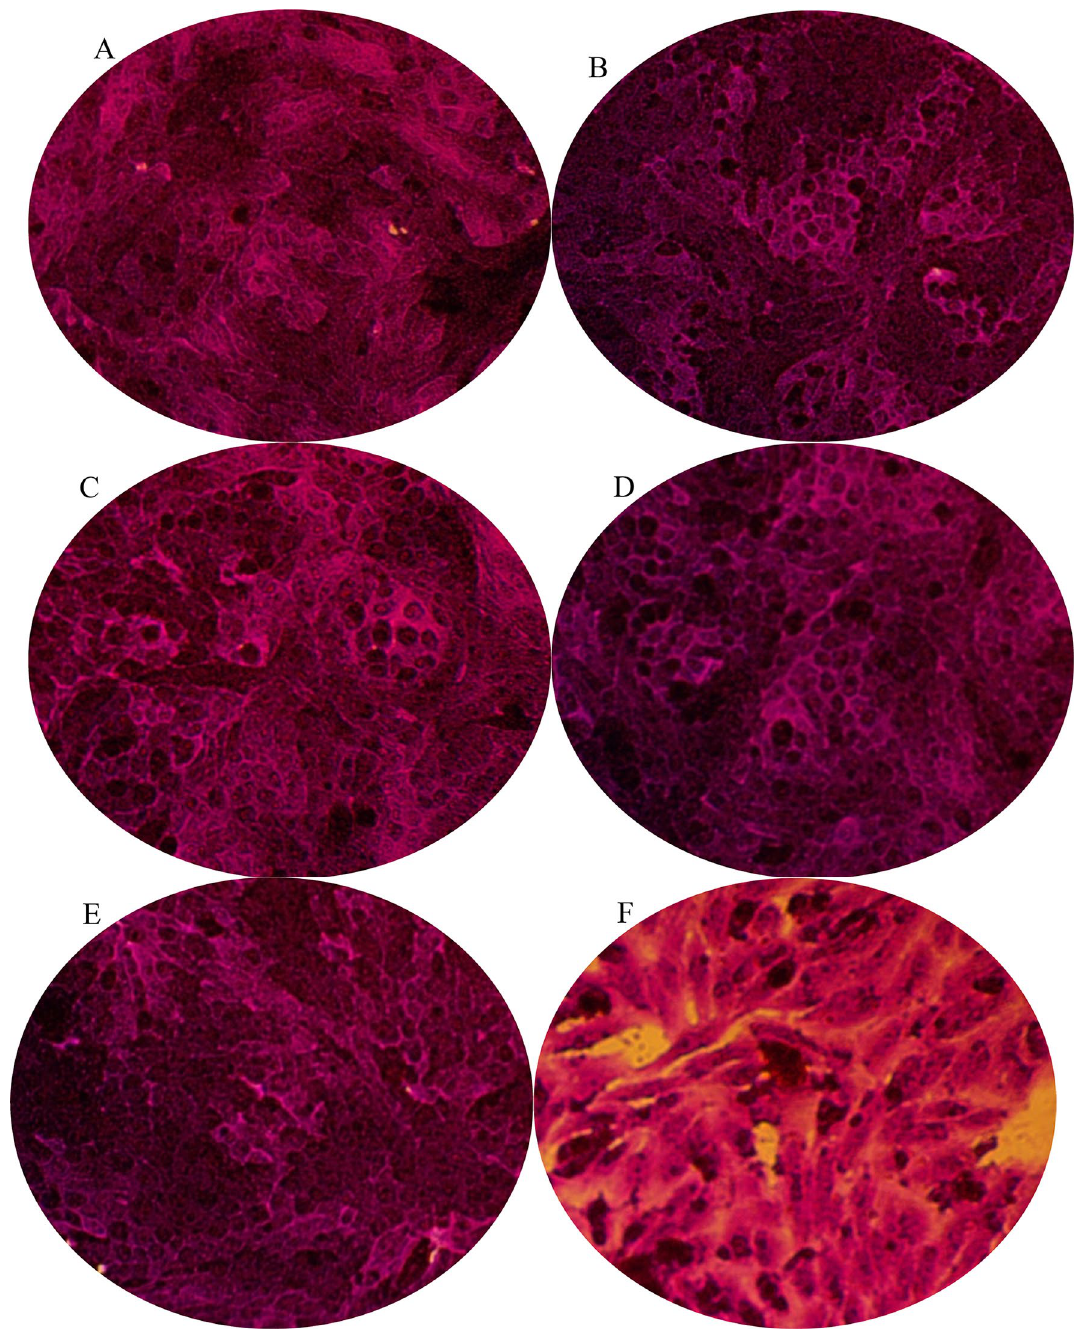
Figure 6. Morphological alteration of treated HepG2 by different concentration of D. caffra fruit extract. ( a ) control; ( b ) 0.1 µg; ( c ) 1 µg, ( d ) 10 µg; ( e ) 100 µg; ( f ) 1000 hand. The hydrogen bonds formed between the receptors and the chlorogenic acid were used to rank the bind- ing affinity and were presented as the free binding energy (S, kcal/mol). Chlorogenic acid showed the highest docking score of − 6.9689 kcal/mol with (6U7H) which is higher than that of the other protein (1HZO) with − 6.5072 kcal/mol. Tables 5 and 6 reveal the following results: chlorogenic acid have a higher negative score of free binding energy with both proteins (6U7H) and (1HZO), indicating the applicability of chlorogenic acid by encouraging antivirus and antibacterial drugs that could help medicinal chemists and pharmaceuticals further design and synthesize more effective drug candidates. The HCoV-229E protein (6U7H) interacted via amino acid pocket molecules with O 41and O 17 by donating their H atoms or accepting H atoms through O ALA 710 and NH2 ARG 689 receptors. The interaction with Proteus vulgaris protein (1HZO) formed one hydrogen donor atom between O19 in ligand and ASP 176 amino acid receptor, in addition to the two hydrogen acceptor interac- tion between O17 and O23 atoms in ligand and GLY 175 and ARG65 amino acids receptors, respectively. The